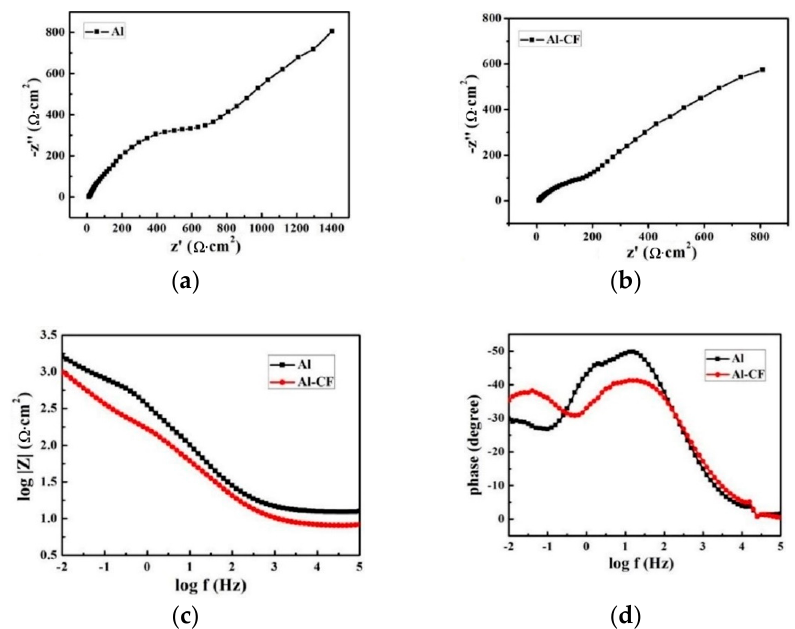
Figure 7. Electrical impedance spectroscopy (EIS) of Al coating and Al-CF composite coating; ( a ) Nyquist plots of the Al coating, ( b ) Nyquist plots of the Al-CF coating, and ( c , d ) bode plots of the Al coating and the Al-CF coating.